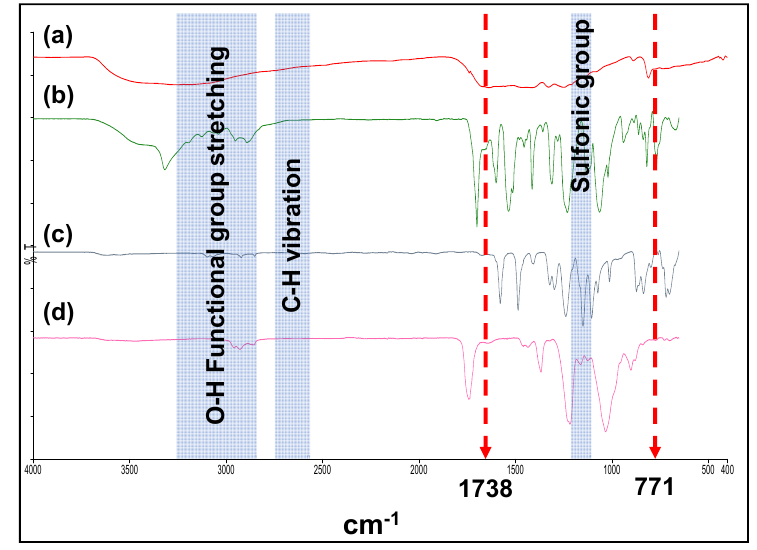
Figure 3. FTIR spectra for (a) OGCN catalyst particle; (b) LSMM (hydrophilic surface modifying macromolecules) additive; (c) PES18wt% membrane; and (d) PES/LSMM ‐ OGCN membrane.